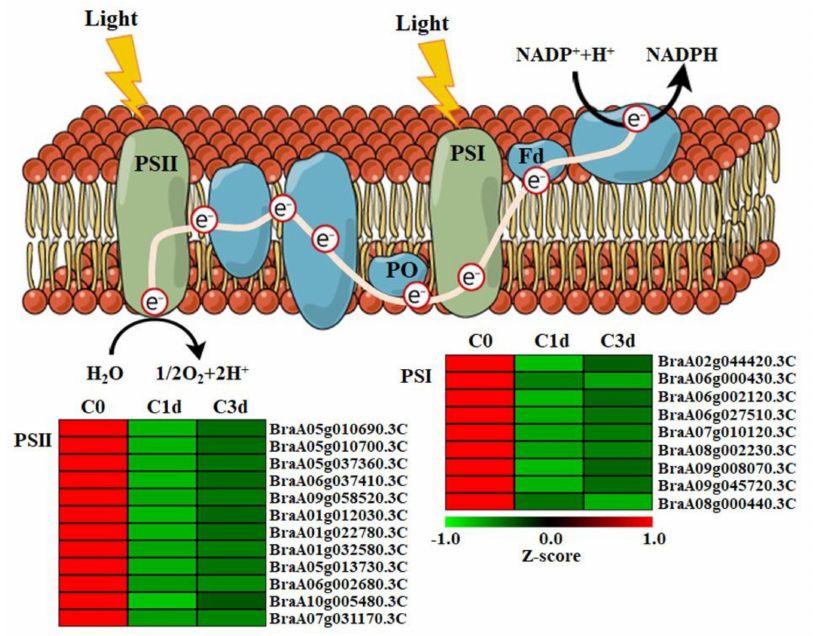
Figure 3. Effects of cold stress on the transcription levels of genes involved in the light reactions. C0, plants grown at 20 ◦ C (control plants); C1d and C3d, plants subjected to cold stress (10 ◦ C) for 1 day and 3 days, respectively. Red and green colors indicate ascending and descending Z-scores,